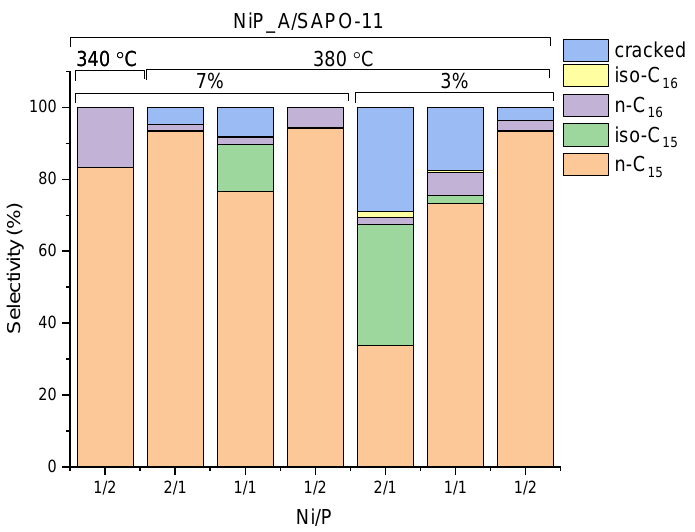
Figure 5. Product distributions after 5 h of reaction (X MP = 100%) in an autoclave over NiP_A/SAPO- 11 samples with different Ni contents and Ni/P molar ratios. 3 MPa, V H2 = 100 mL/min, 500 RPM, V cat = 1.5 mL (for 7 wt.% m cat = 1 g, for 3 wt.% m cat = 0.85 g). At this point, 3 wt.% NiP_A/SAPO-11 (Ni/P = 2/1) showed the highest isomerization activity, but the number of cracked products was the highest among all tested catalysts.